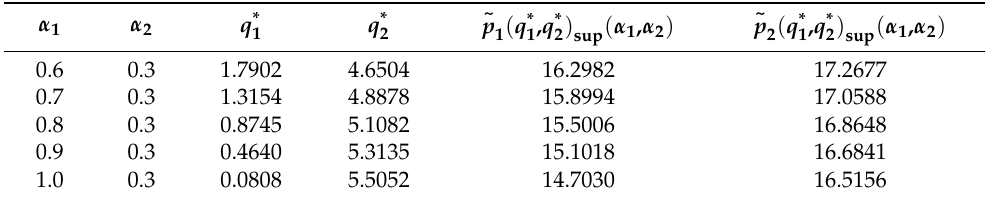
Table 9. ( α 1 , α 2 )-optimistic equilibrium quantity for Scenario III when CDT’s risk aversion levels increase.